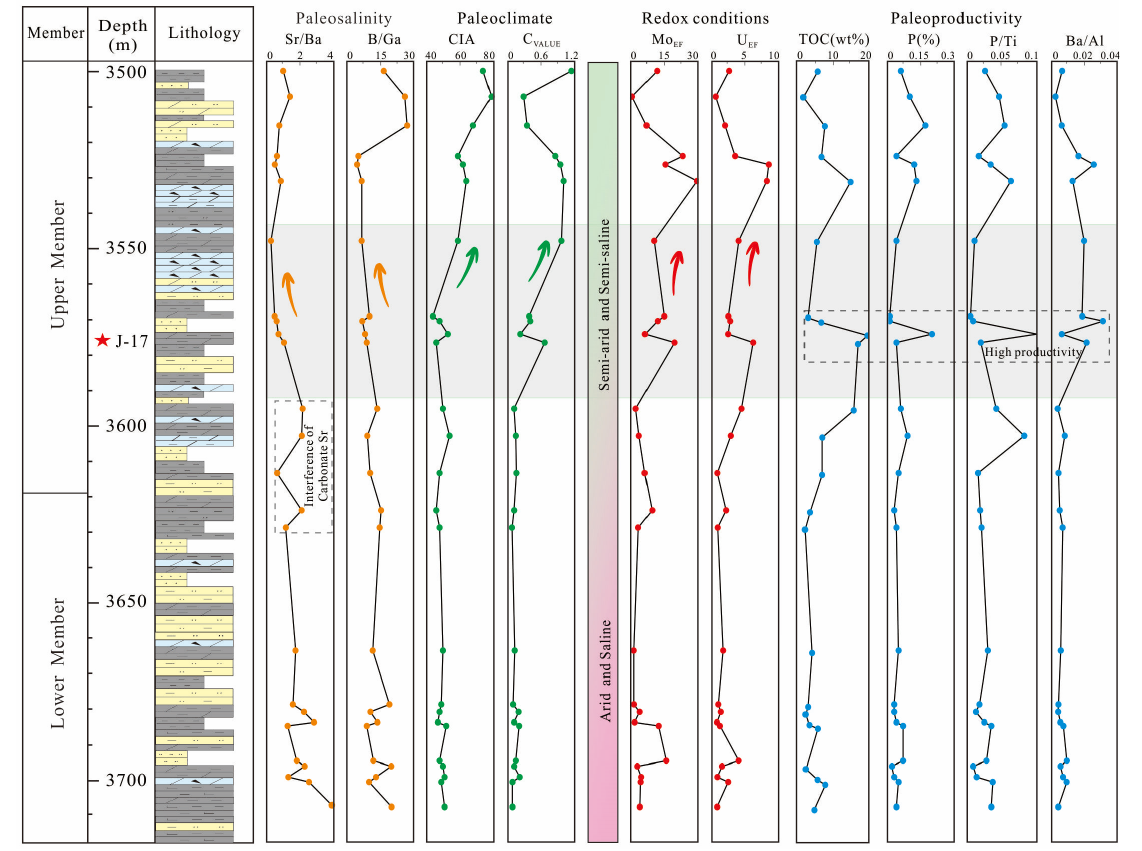
Figure 9. TOC and element geochemical parameters of the Lucaogou Formation (the red star marks the sample location of the microfossil J-17, 3574.2 m).